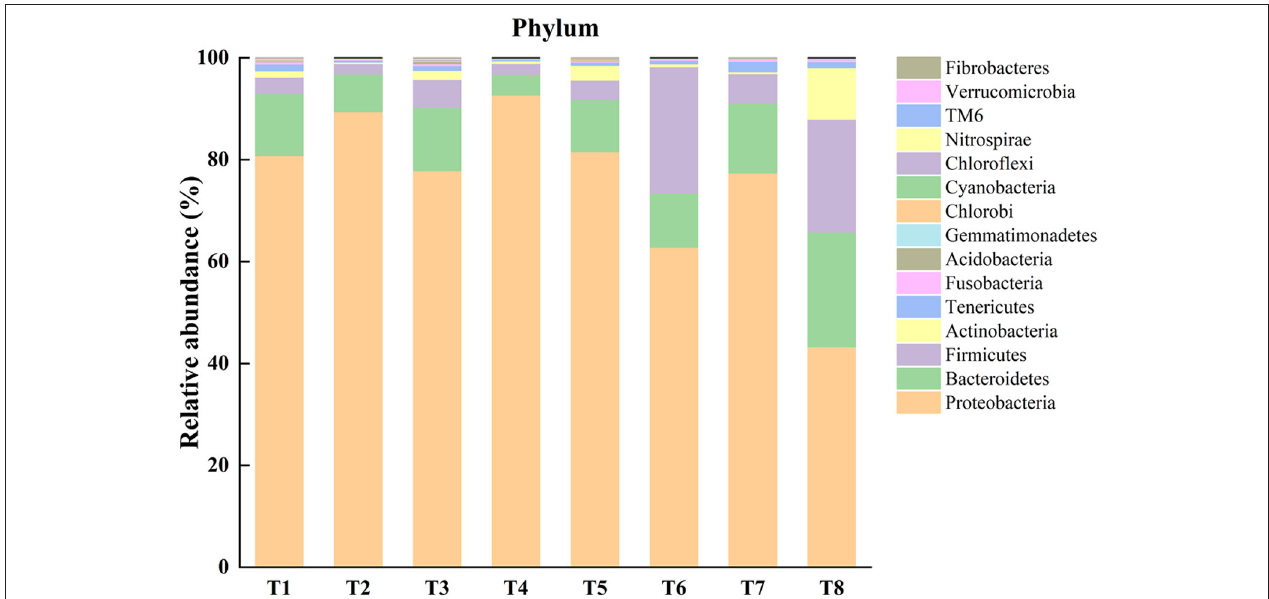
FIGURE 1 | Representing relative abundance of top 15 phyla of microbiota in each sample of different experimental treatments [T1 (DO 6mg L − 1 × pH 8.1 × 20 ◦ C), T2 (DO 6mg L − 1 × pH 8.1 × 30 ◦ C), T3 (DO 6mg L − 1 × pH 7.7 × 20 ◦ C), T4 (DO 6mg L − 1 × pH 7.7 × 30 ◦ C), T5 (DO 2mg L − 1 × pH 7.7 × 20 ◦ C), T6 (DO 2mg L −